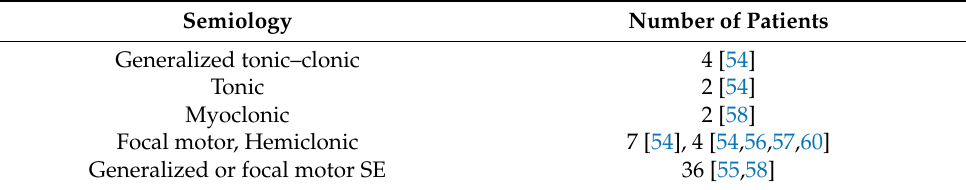
Table 7. Status Epilepticus semiology in patients with Wolf-Hirschhorn Syndrome.